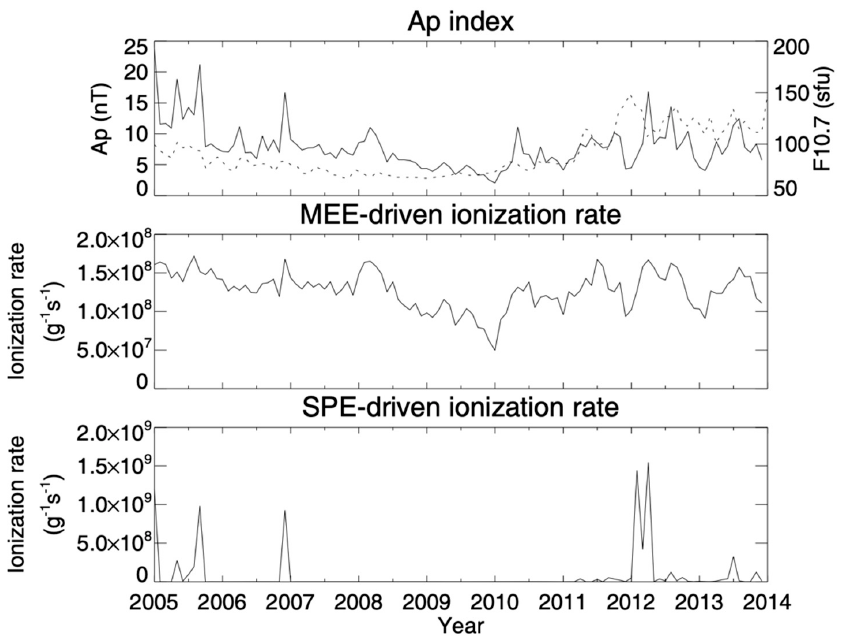
Figure 1. Monthly mean Ap (soild line) and F10.7 (dotted line) indices during the period from 2005 to 2013 are presented at the top panel. Zonally averaged ionization rates at 70 km altitude and 66° geographic latitude are also shown in the next panels by medium-to-high energy electrons (MEE) and by solar proton event (SPE) during the study period.